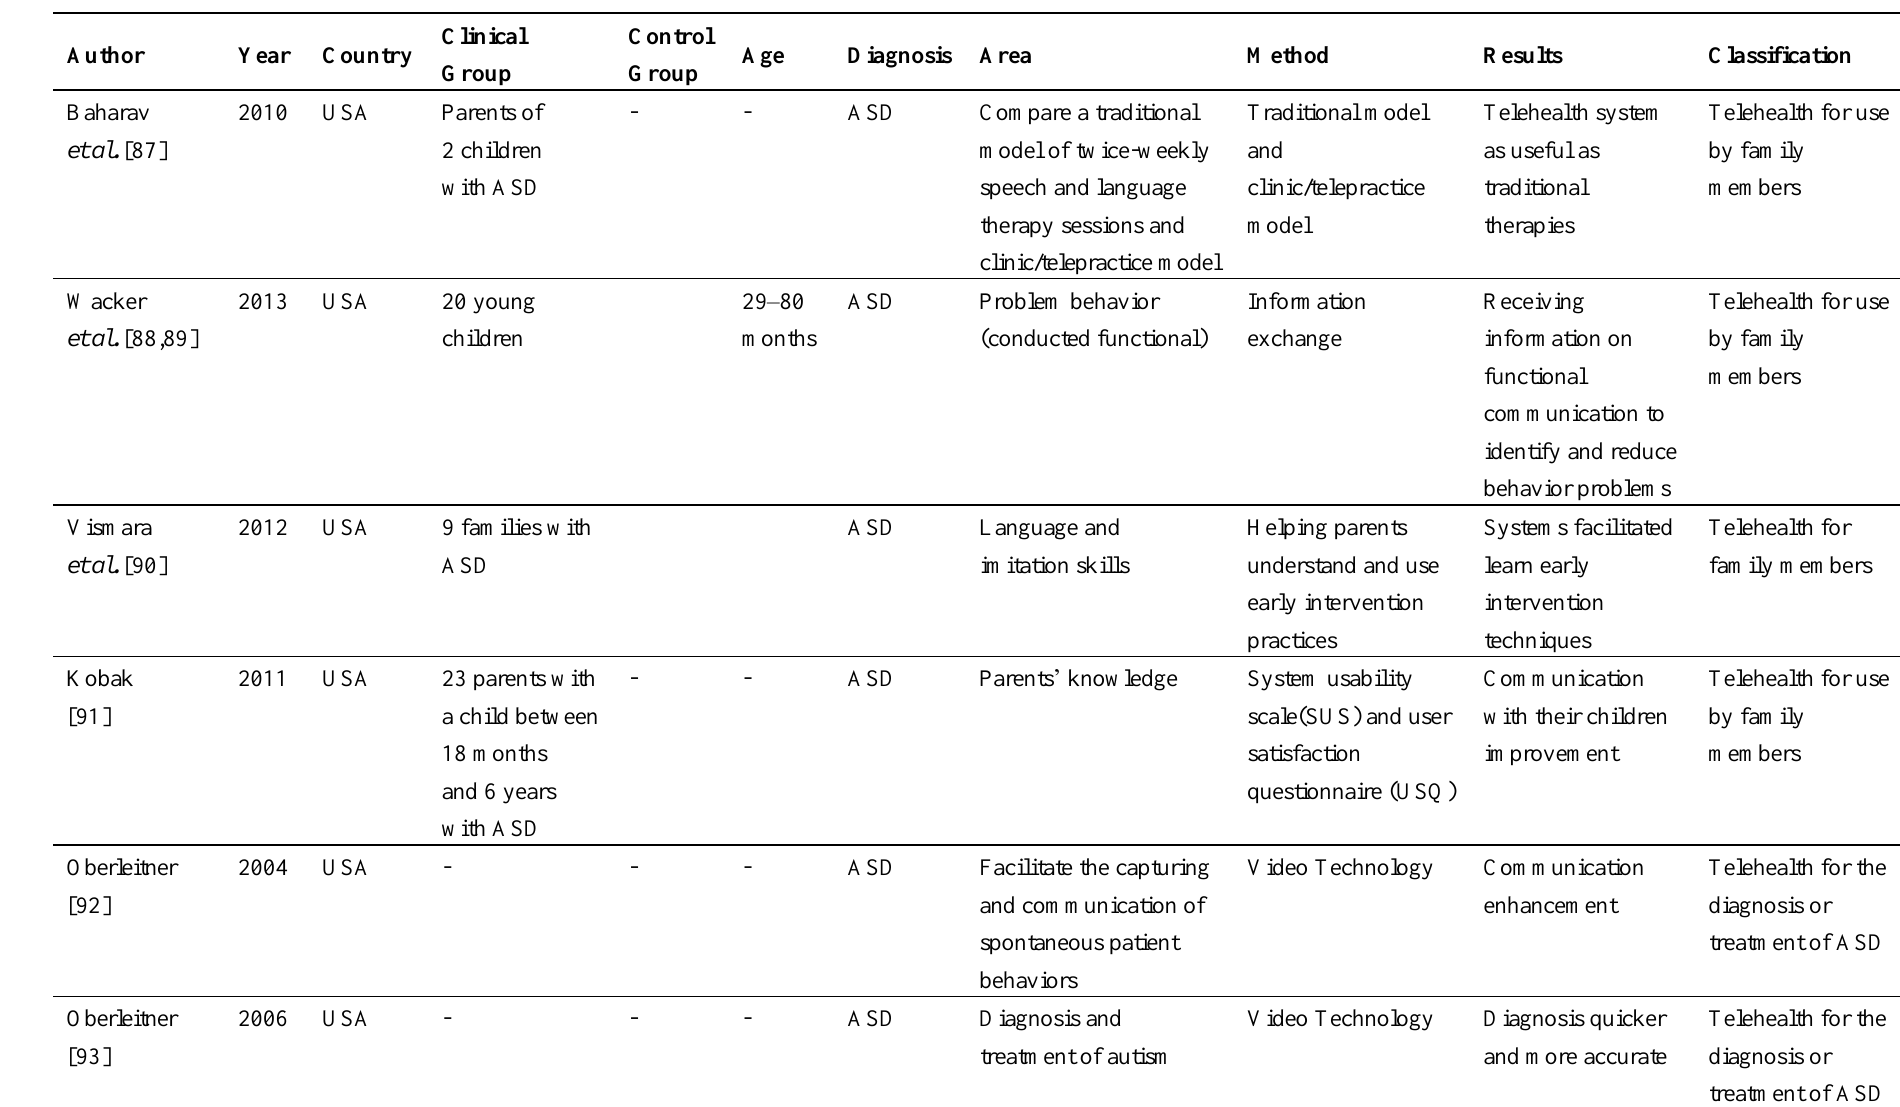
Table 3. Studies on Telehealth